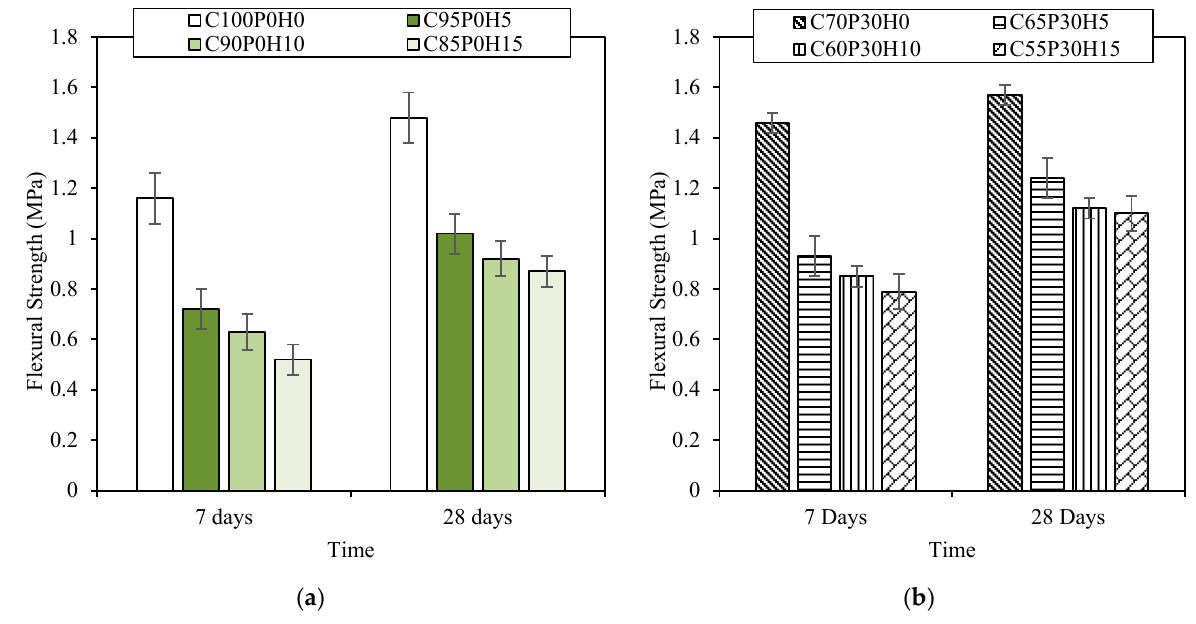
Figure 5. Flexural strength against time for ( a ) C100-BFCs and ( b ) C70-BFCs.